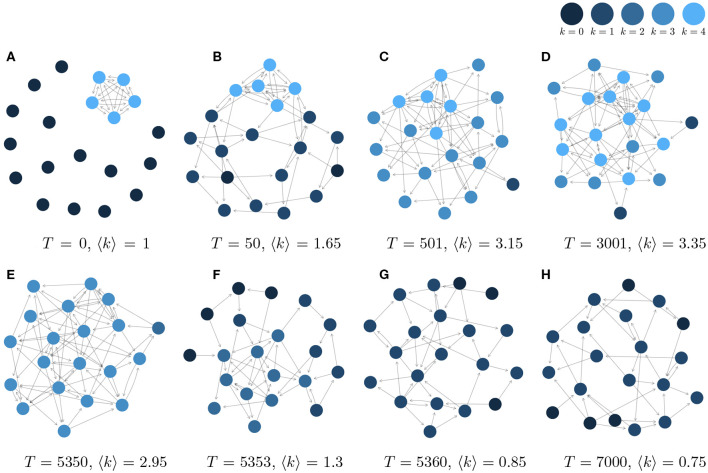
Some instances from the graph evolution of a 20-nodes network. (A)
T = 0, 〈k〉 = 1. (B)
T = 50, 〈k〉 = 1.65. (C)
T = 501, 〈k〉 = 3.15. (D)
T = 3001, 〈k〉 = 3.35. (E)
T = 5350, 〈k〉 = 2.95. (F)
T = 5353, 〈k〉 = 1.3. (G)
T = 5360, 〈k〉 = 0.85. (H)
T = 7000, 〈k〉 = 0.75.